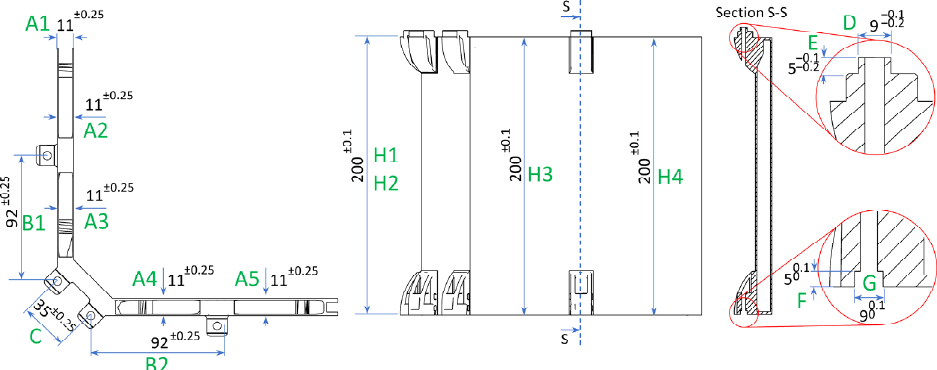
Figure 16. Component dimensions and tolerances and measured zones (in green).